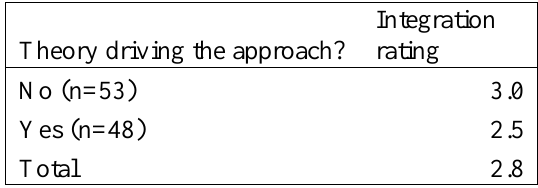
Table A4.4 Average integration rating for studies that used/not used theory to drive the social- ecological approach employed. Integration ratings were calculated for resilience theory (2.4, n=17), Common-pool resource theory (2.8, n=10), and systems theory (3.5, n=10). All other theories had small sample size.